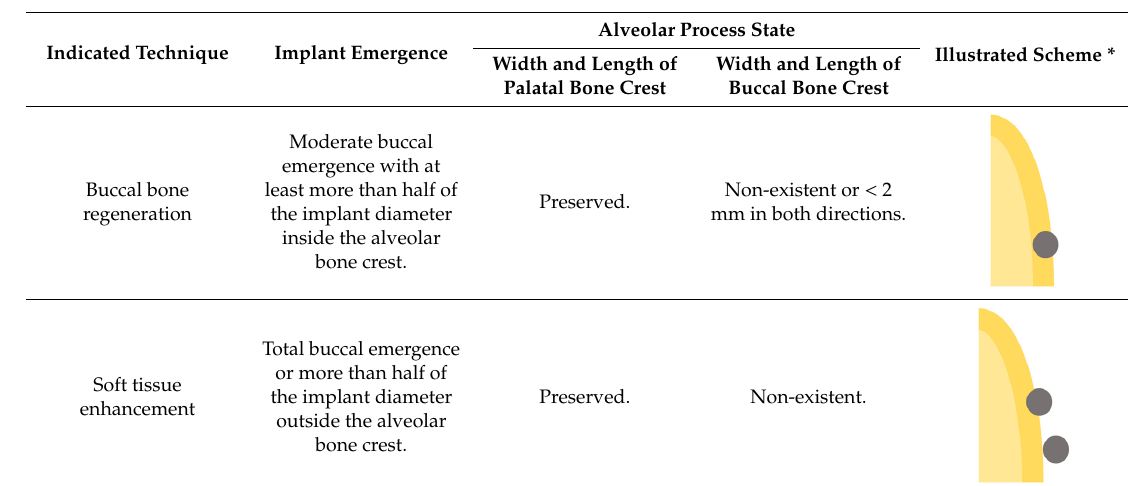
Illustrated scheme: this scheme represents an occlusal view of the implant emergences in relation with the edentulous maxillae. The gray points are the emergence of zygomatic